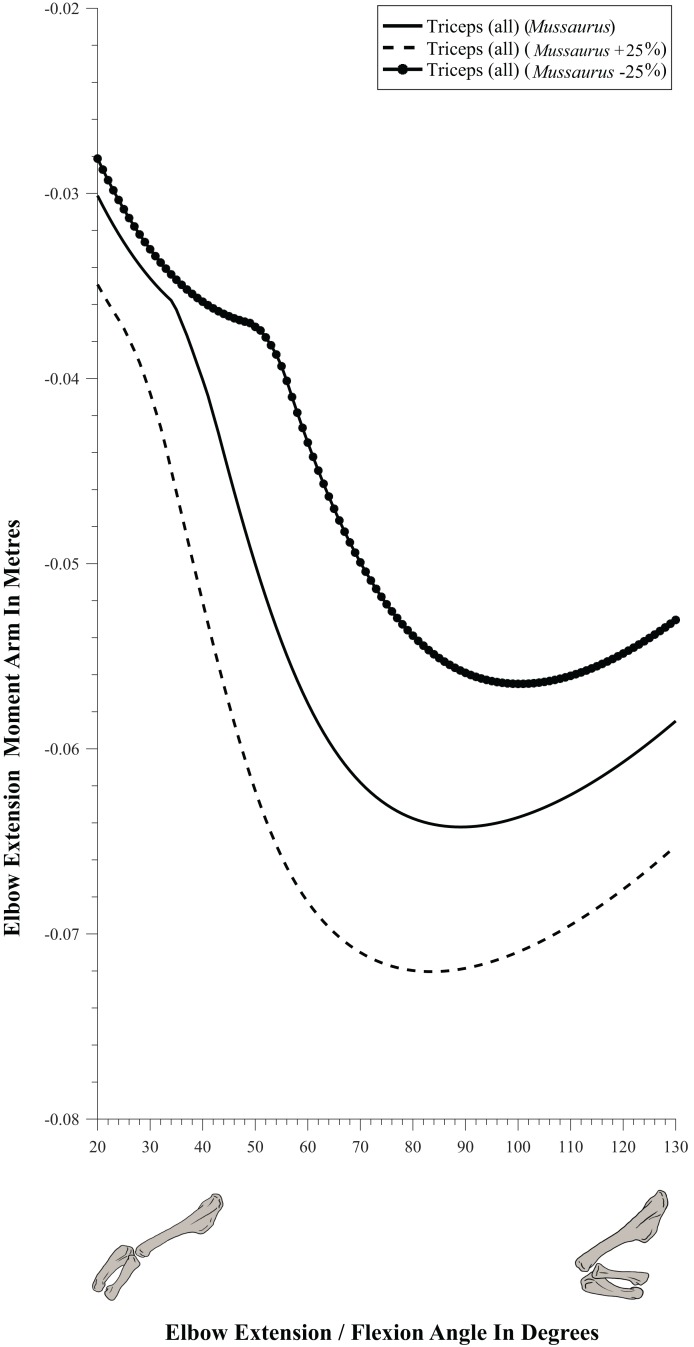
Sensitivity analysis of elbow extensor muscles in Mussaurus patagonicus.Moment arms around the elbow joint (not normalized), plotted against extension/flexion joint angles for Mussaurus in the resting pose; for various elbow cartilage assumptions (see Fig. 13 and Materials and Methods). Negative moment arms correspond to extension. Zero elbow angle corresponds to full extension, while larger angles correspond to flexion. For muscle abbreviations see Table 1.